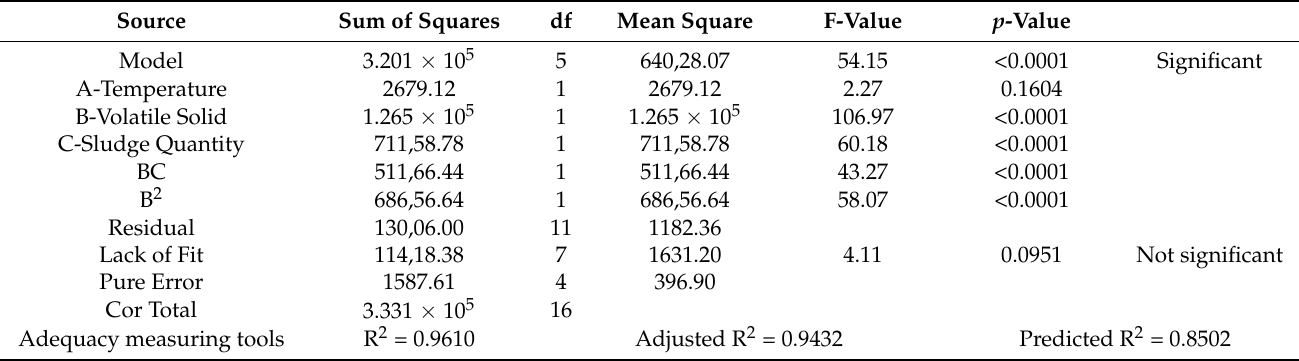
Table 10. ANOVA table for CH 4 /g-VS